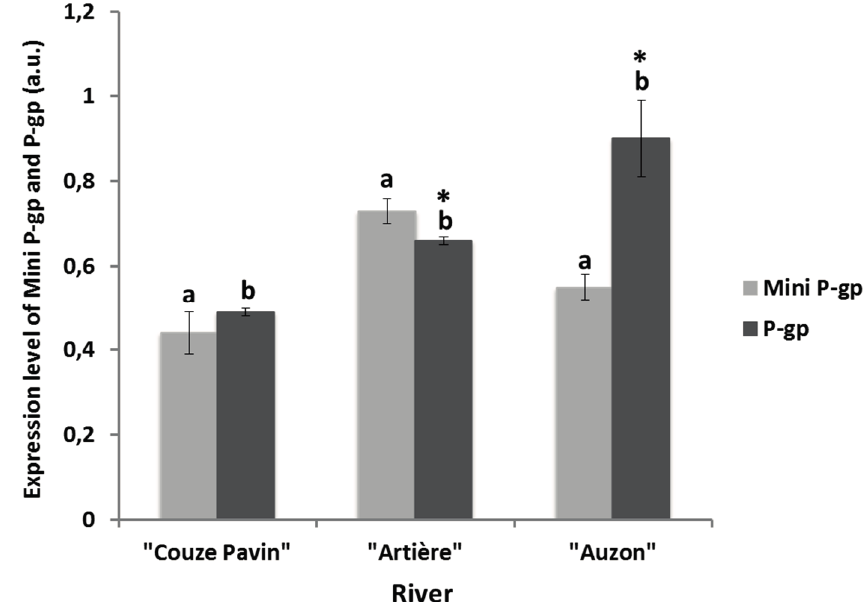
Figure 4. Co-expression of mini-P-gp and P-gp in brown trout erythrocytes from different rivers. The red blood cells were taken from brown trout at sampling sites of different rivers with GPS coordinates: “Couze Pavin” (N 45°30'54.7" E 002°55'24.3"), “Artière” (N 45°45'10.7" E 003°07'13.4") and “Auzon” (N 45°42'53.0" E 003°11'09.9"). Proteins were analyzed in total protein extract from red blood cells using Western blot